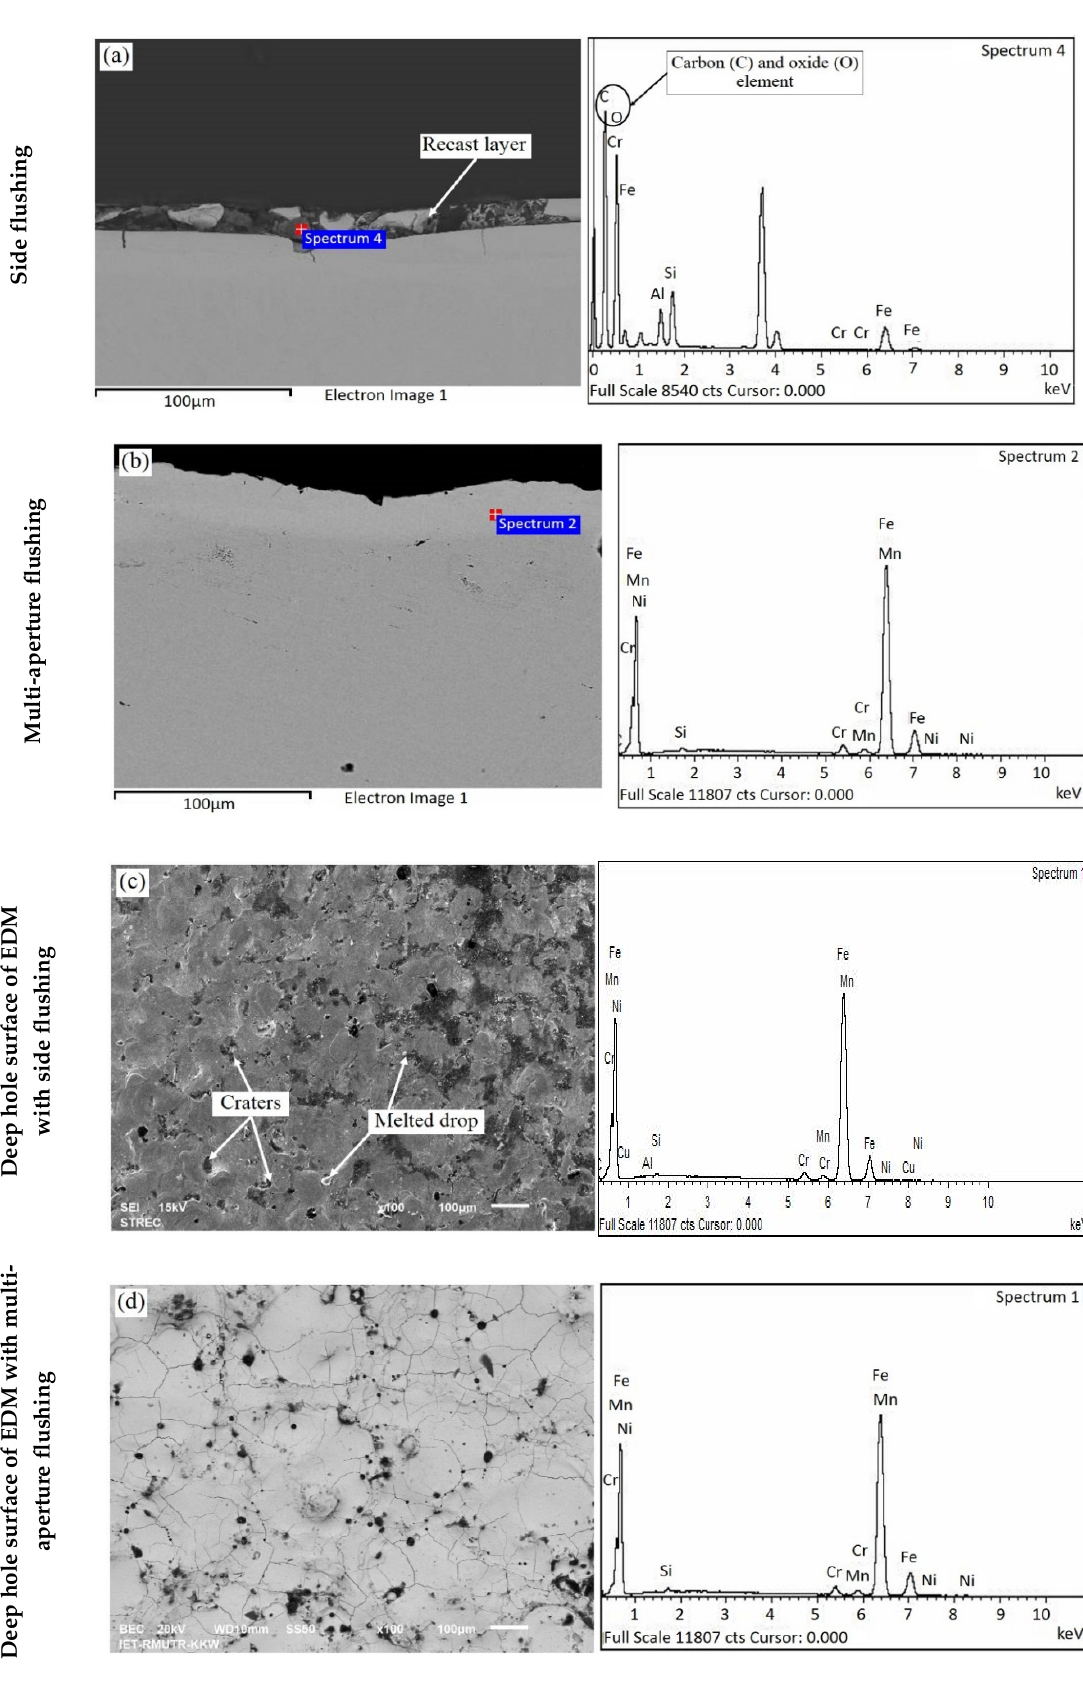
Figure 13. SEM images and EDS compositional analysis at 30 mm machining depth: ( a ) cross-sectional view of side flushing, ( b ) cross-sectional view of multi-aperture flushing, ( c ) deep hole surface of side flushing, ( d ) deep hole surface of multi-aperture flushing. Table 14. EDS analysis of cross-sectional view and top view of deep hole surface of EDM with side and multi-aperture flushing at 30 mm machining depth.